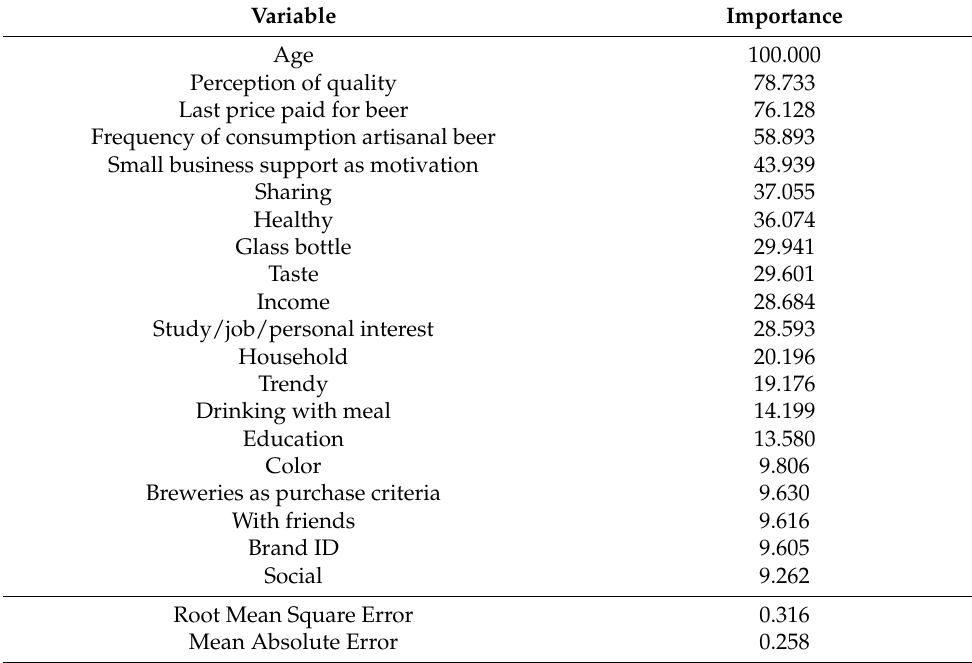
Table 5. Results from the random forest regression